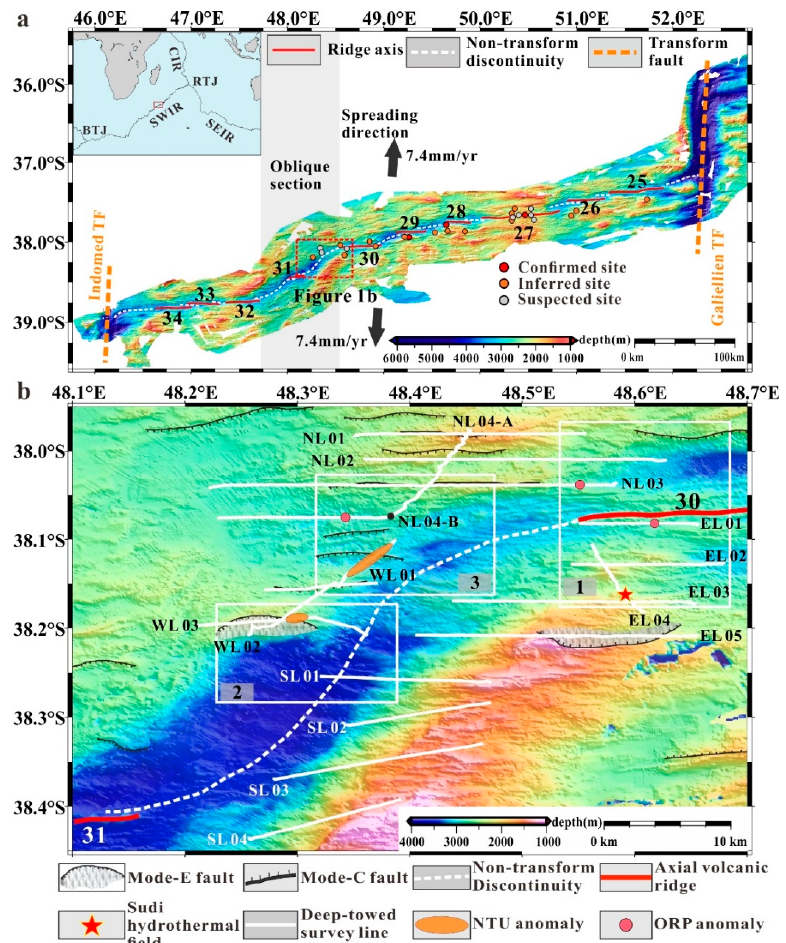
Figure 1. Geological background of our study area on SWIR. ( a ) Bathymetry, segmentation and hydrothermal sites between Indomed and Gallieni TFs. (The bathymetry is from multibeam sonar data by Chinese Dayang cruises.) The top-left inset shows the location between the In-Ga TFs. SWIR: Southwest Indian Ridge; CIR: Central Indian Ridge; SEIR: Southeast Indian Ridge; BTJ: Bouvet triple junction; RTJ: Rodrigues triple junction. ( b ) Detailed bathymetry of our study area. Labels are the names of survey lines, marking the start point (line NL04 is divided into 2 parts owing to the change in heading direction, and the black dot is the turning point). The study area is divided into 4 regions according to the distribution of deep-towed survey lines (i.e., northern, southern, western and eastern regions, marked by the first letter in name of survey line). White boxes with numbers 1, 2 and 3 denote the areas shown in three-dimensional view presented in Figures 7, 8 and 9, respectively. NTU denotes Nephelometric Turbidity Units and ORP denotes the oxidation reduction potential. Note that normal faults are only analyzed from bathymetry data and do not represent entire faults of our study area, and the mode-E faults have greater heaves and spacings than mode-C faults do (the names of these 2 mode faults are simplified from Center-mode fault and Ending-mode fault, which are defined by Benh and Ito, 2008 [32]) (faults data from